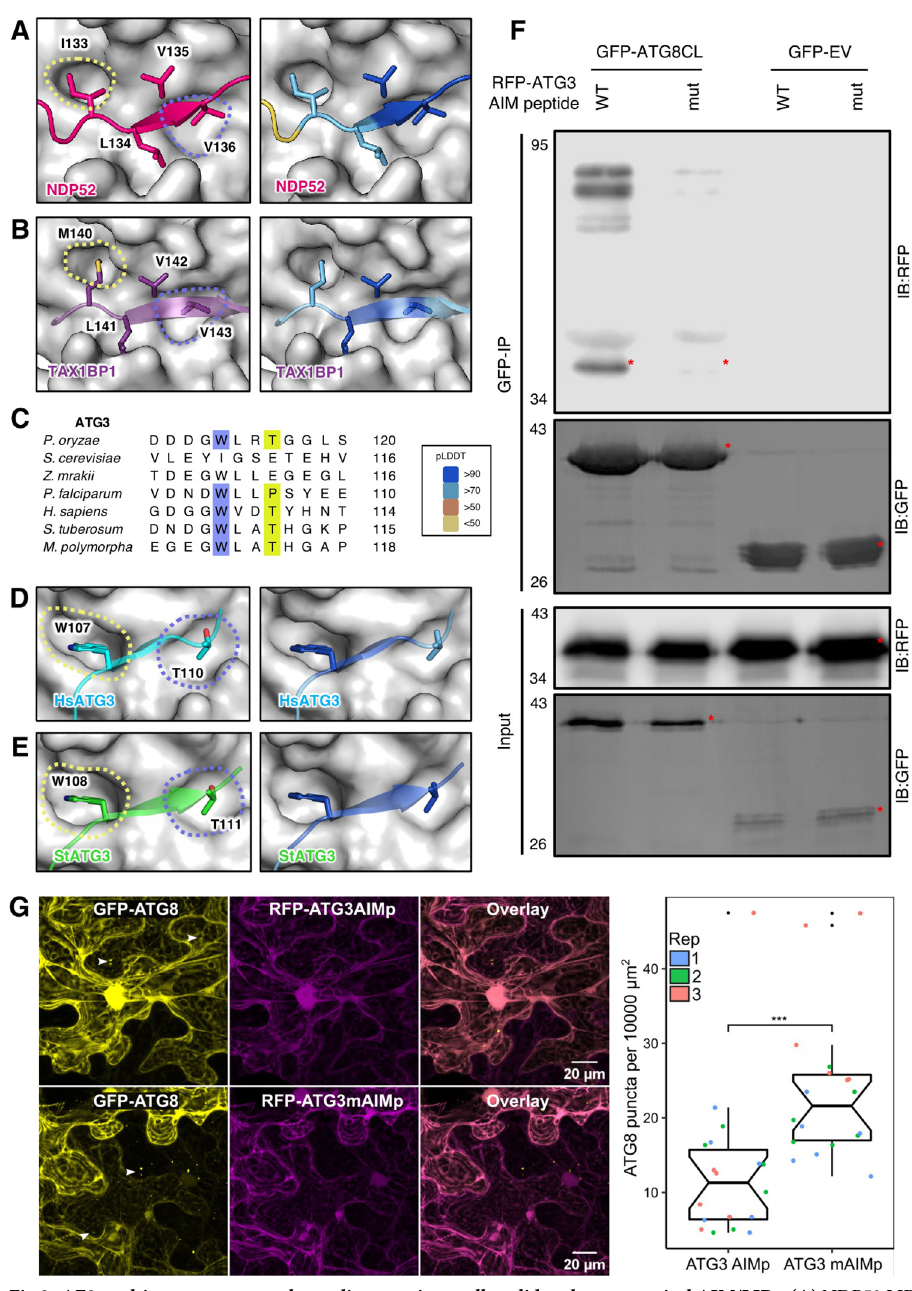
Fig 3. AF2-multimer can accurately predict experimentally validated noncanonical AIM/LIRs. (A) NDP52 LIR in complex with LC3C. Beyond the LIR pockets, W- (yellow) and L- (slate) sites, NDP52 (dark pink) utilises resides LEU134 and VAL135 to form additional interactions to provide specificity, as shown in literature. AF2-multimer predicts this complex with high confidence. (B) TAX1BP1 LIR in complex with LC3A. Beyond the LIR pockets W- (yellow) and L- (slate) sites, TAX1BP1 (purple) utilises resides LEU141 and VAL142 to form additional interactions to provide specificity, as shown in literature. AF2-multimer predicts this complex at a high confidence. (C) The noncanonical LIR of ATG3 is conserved in all but 2 species studied for this project. (D, E) ATG3 (human–cyan, S . tuberosum –green) AIM/LIR in complex with ATG8-family members. Residues TRP and THR are arranged in a noncanonical AIM/LIR, as shown in literature. Right-hand side of panels A, B, D, and E are coloured based on the AF2-calculated prediction confidence score; pLDDT. Blue indicates regions of a protein with a score of over 90, meaning a very high confidence prediction. Scores between 70 and 90 are represented with light blue, which accounts for a high confidence score. Scores between 50 and 70 are considered low (orange) and anything below 50 is a very low confidence prediction (yellow). (F) In planta co-immunoprecipitation between ATG8CL and ATG3 AIM peptide